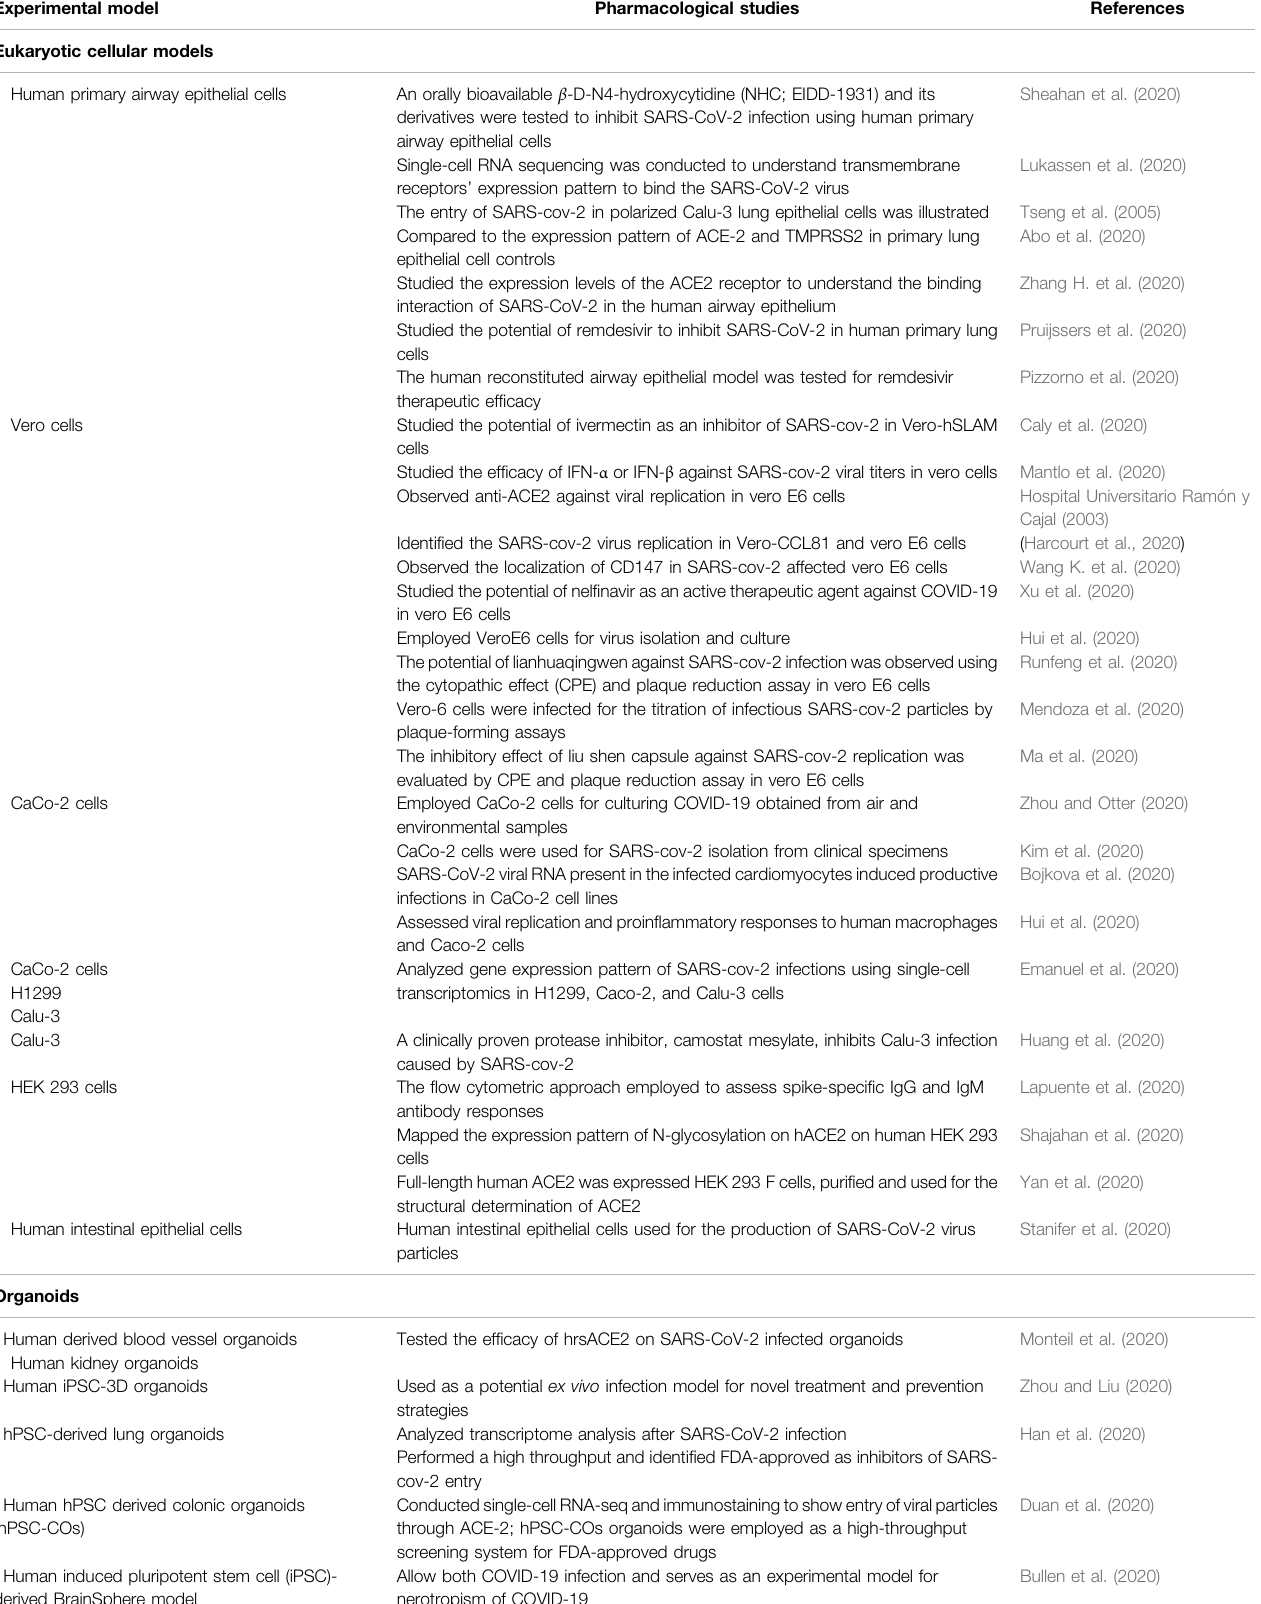
TABLE 2 | List of cell lines and organoids used for SARS-CoV-2 culture, treatment, and prevention strategies. Experimental